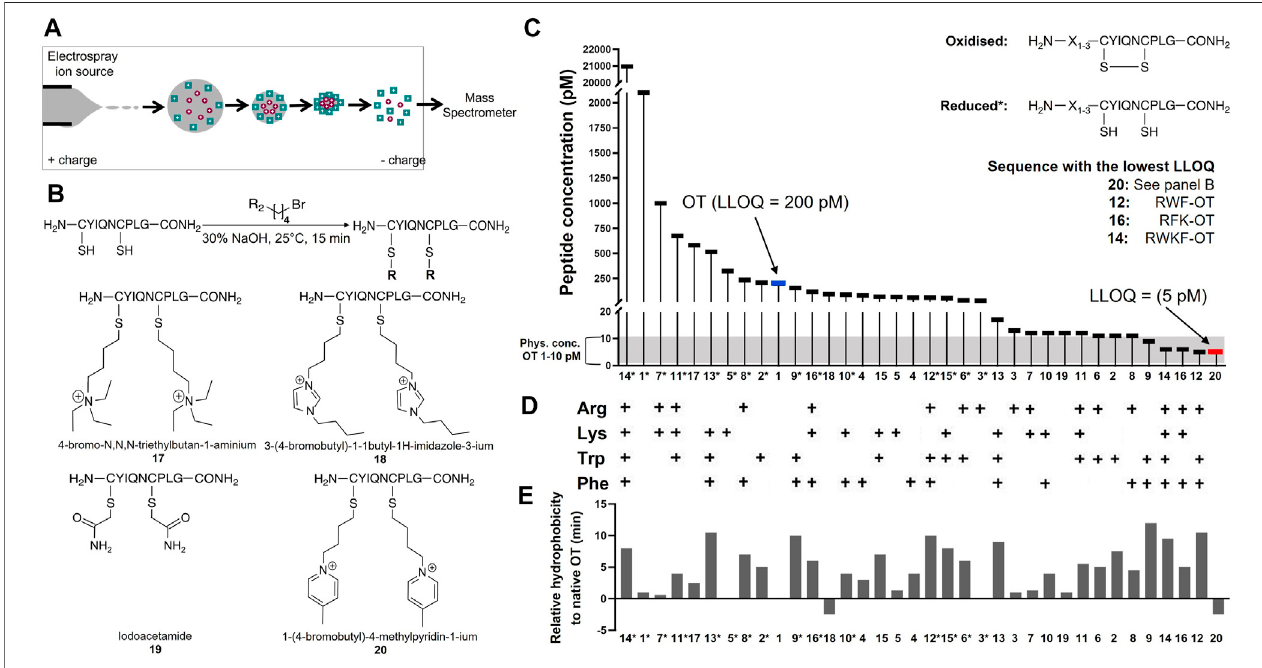
FIGURE 3 | Improving MS sensitivity by modifying OT ’ s hydrophobicity and charge state. (A) Analytes form spherical droplets upon electrospray ionization in an ESI- MS.Hydrophilicanalytestend toremainmoreinthecenteroftheionizationdroplets,resultinginlessef fi cientionizationcomparedtomorehydrophobicanalytesthattendto remain on the surface of the droplets. (B) Derivatization of OT with positively charged small molecule moieties. (C) LLOQs of synthesized and derivatized OT analogues. *Indicates reduced peptides. (D) Presence of amino acids Arg, Lys, Trp, and Phe in studied OT analogues. (E) Relative hydrophobicity on a C 18 -RP HPLC column compared to OT. Values > 0 indicate more hydrophobic peptides (longer retention time), while < 0 indicate more hydrophilic peptides (shorter retention time) than OT.